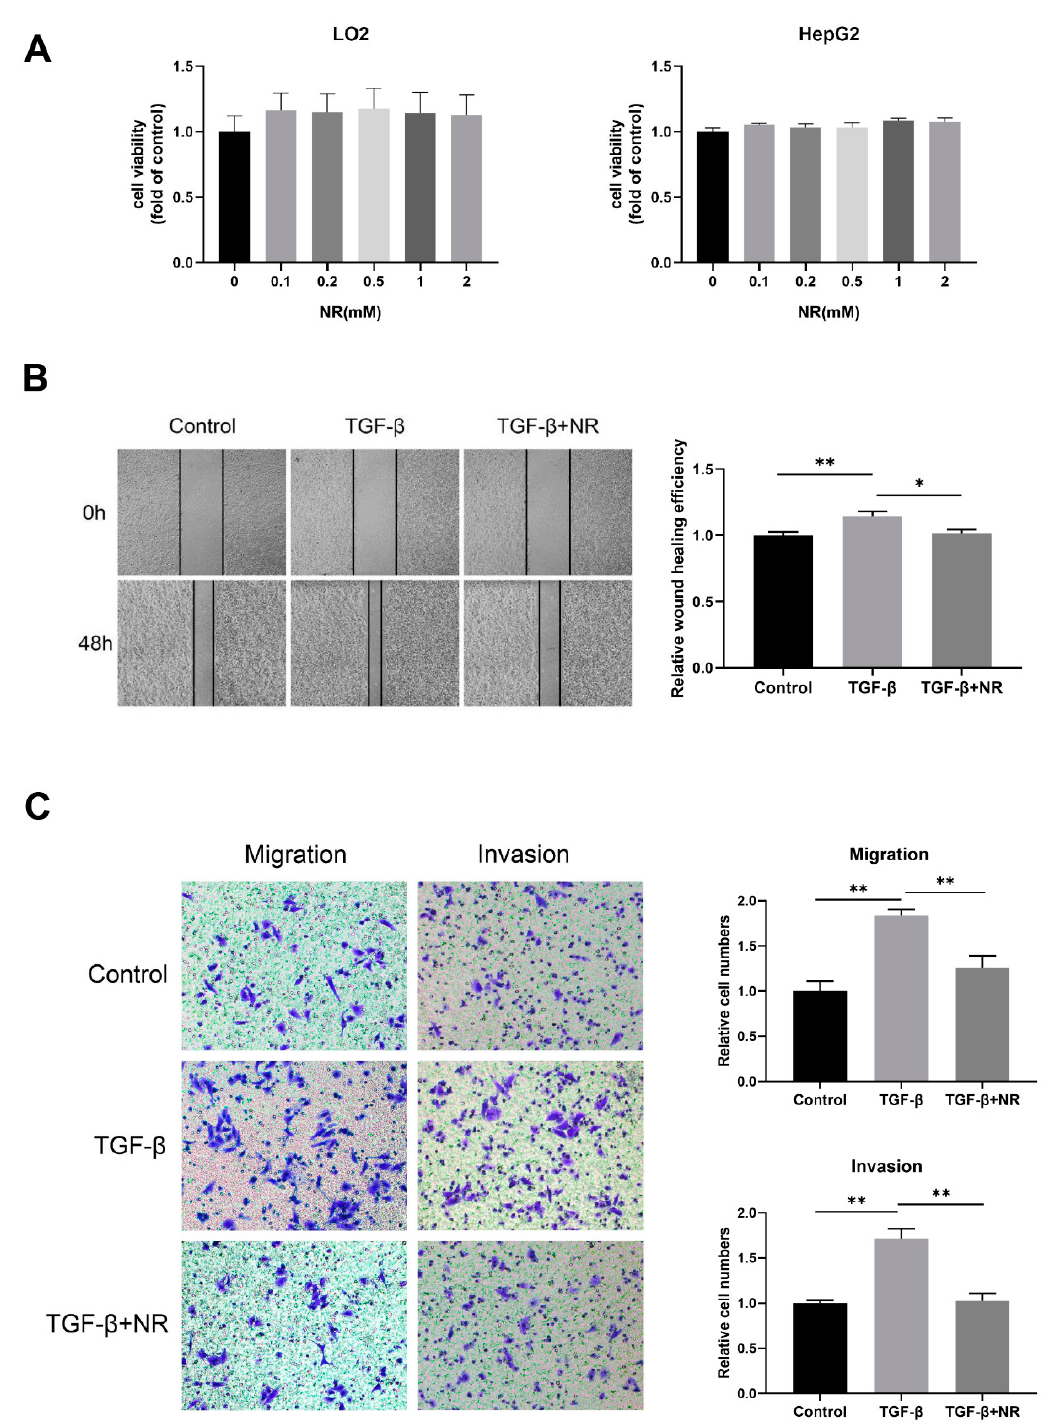
Figure 6. NR inhibited migration and invasion of HepG2 cells. ( A ) The cell viability of LO2 and HepG2 cells after 48-h NR treatment. ( B ) Wound-healing assay showing cell migration of HepG2 cells after 48 h. ( C ) Transwell assays showing cell migration and invasion of HepG2 cells after 24 h. n = 3; * p < 0.05, ** p < 0.01 compared to the TGF- β group. p -values were calculated using Kruskal – Wallis test and Dunn’s multiple comparisons test ( A ), one-way ANOVA and Tukey’s multiple comparisons test (( B , C )-migration), and one-way ANOVA and Tukey’s multiple comparisons test (( C )-invasion). NR, nicotinamide riboside; TGF- β , transforming growth factor- β